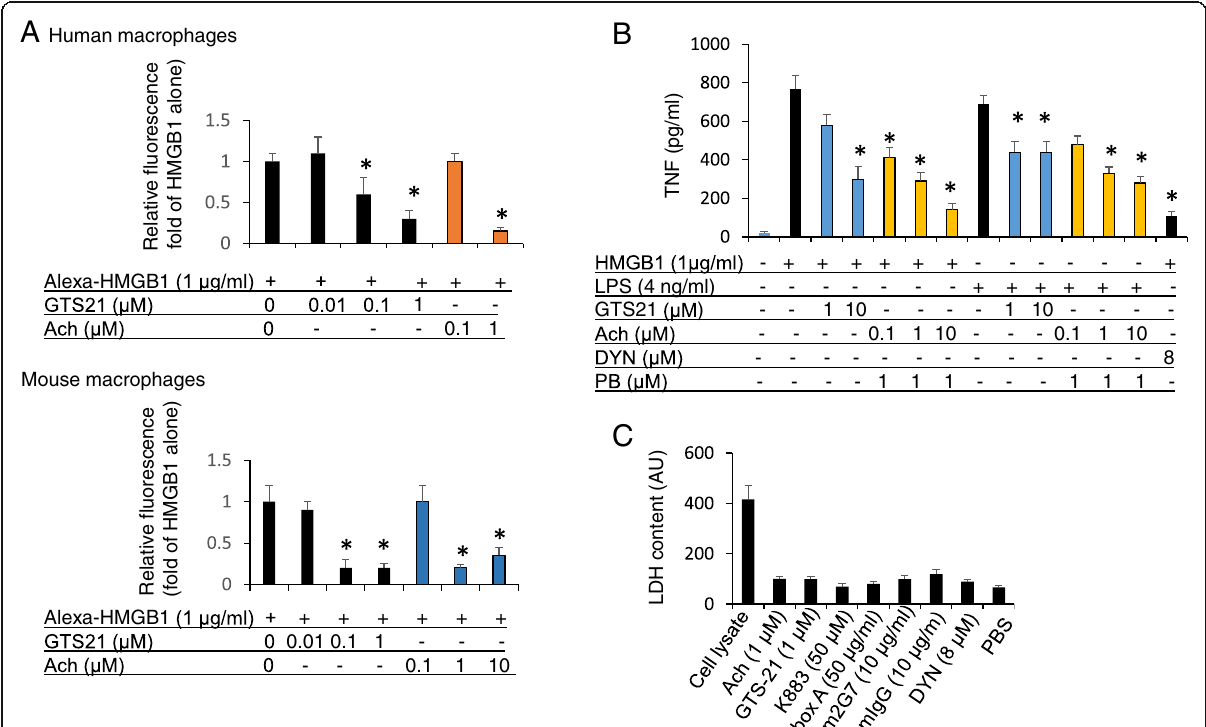
Fig. 5 Cholinergic agonists acetylcholine and GTS-21 inhibited HMGB1 endocytosis, reduced HMGB1 and LPS-induced TNF release in macrophages. a . Primary human macrophages (upper) or thioglycollate-elicited mouse macrophages (lower) seeded on 24-well culture plate on cover slips (1 × 10 4 /well) were incubated with Alexa 555- HMGB1 (1 μ g/ml) alone or plus GTS-21 or acetylcholine for 2 h at 37 °C. Endocytosis results of Alexa 555-HMGB1 were expressed as fold of Alexa 555-HMGB1 alone. N = 32 – 48 cells per treatment. *: P < 0.05 vs. Alexa 555-HMGB1 alone. b . RAW 264.7 cells in 96-well culture plates were used at 90% confluence. Cells were stimulated with HMGB1 or LPS, with the addition of GTS-21, acetylcholine (Ach) as indicated for 16 h. Pyridostigmine bromide (PB) was added (1 μ M). TNF released was measured using ELISA. N = 3 experiments. *: P < 0.05 vs. HMGB1 or LPS alone. c . RAW 264.7 cells in 96-well culture plates (90% confluence) were incubated with Ach, GTS-21, K883, box A, m2G7, mouse IgG (mIgG), or Dynasore (DYN) as indicated for 16 h. Cell lysate (positive control) or supernatants were collected and assayed for LDH content (AU). AU: arbitrary unit. N =